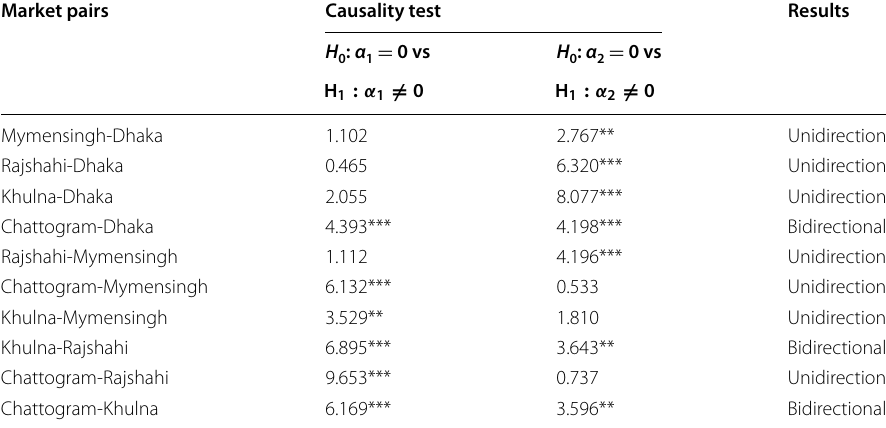
** and *** indicate the null hypotheses are rejected at 1% and 5% level of significant, respectively